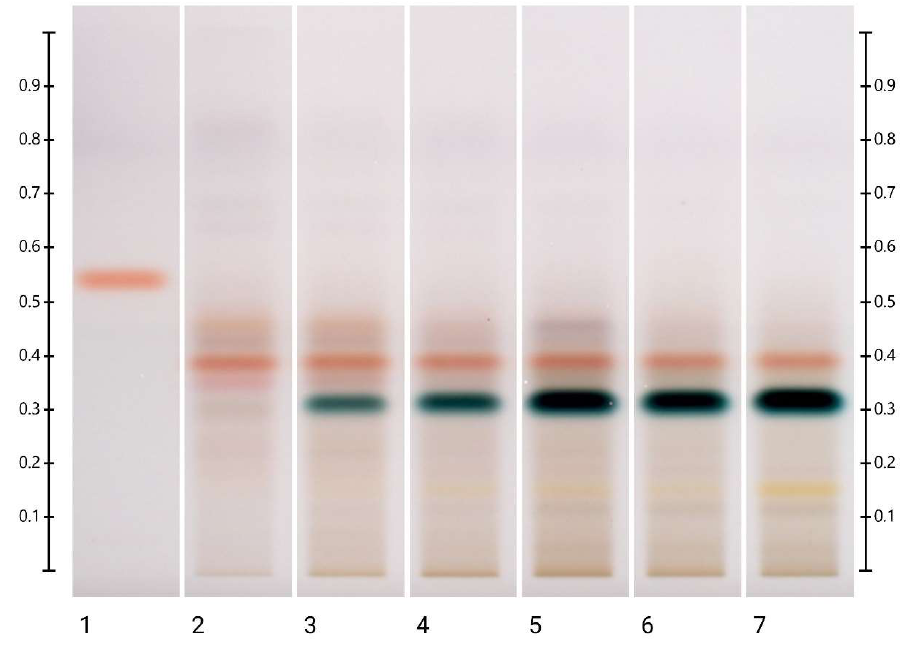
Figure 4. MAR long-term storage at 60 °C. Images taken under white light after derivatisation with vanillin reagent; Track 1—4,5,7-trihydroxyflavanon, Track 2—0 h, Track 3—1 month, Track 4—2 months, Track 5—3 months, Track 6—4 months, and Track 7—5 months; 5 μL of each honey extract, respectively.